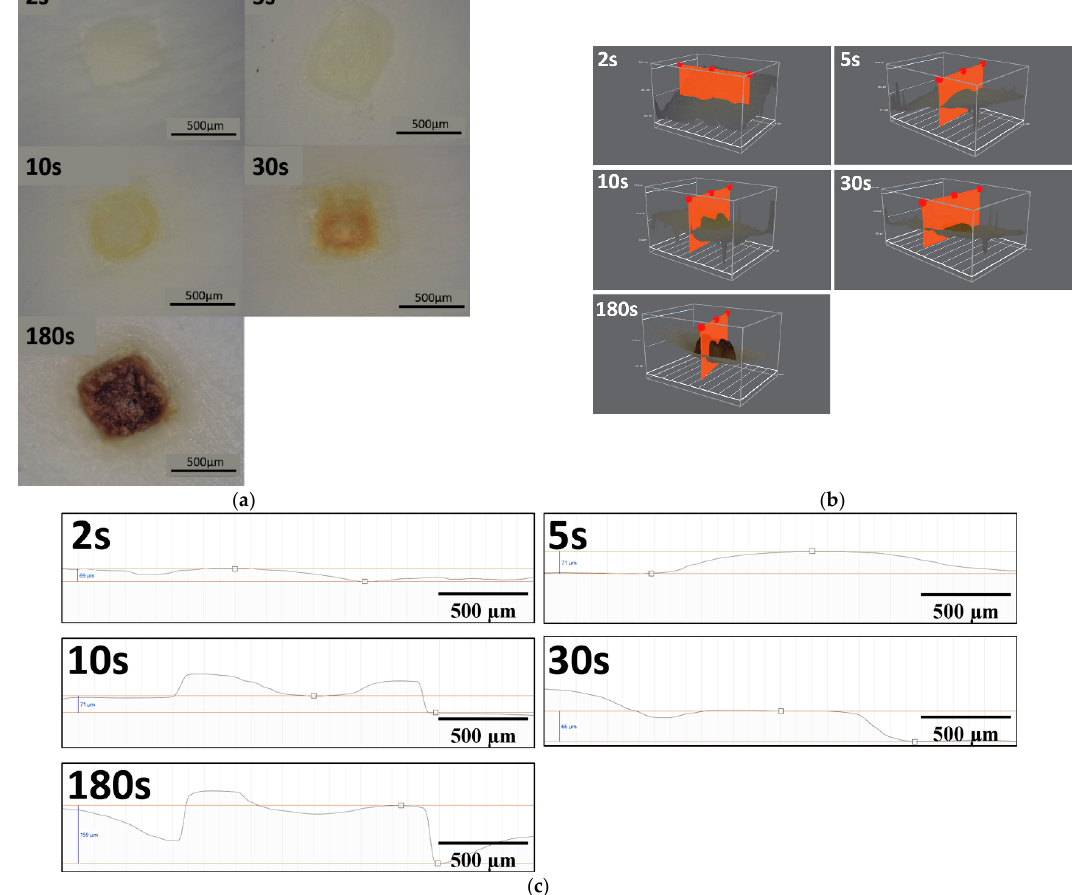
Figure 7. Micrographs of the aortic walls subjected to proton irradiation for exposition time of 2 s, 5 s, 10 s, 30 s, and 180 s; ( a ) top view; ( b ) cross-sectional view; and ( c ) cross-sectional view charts.